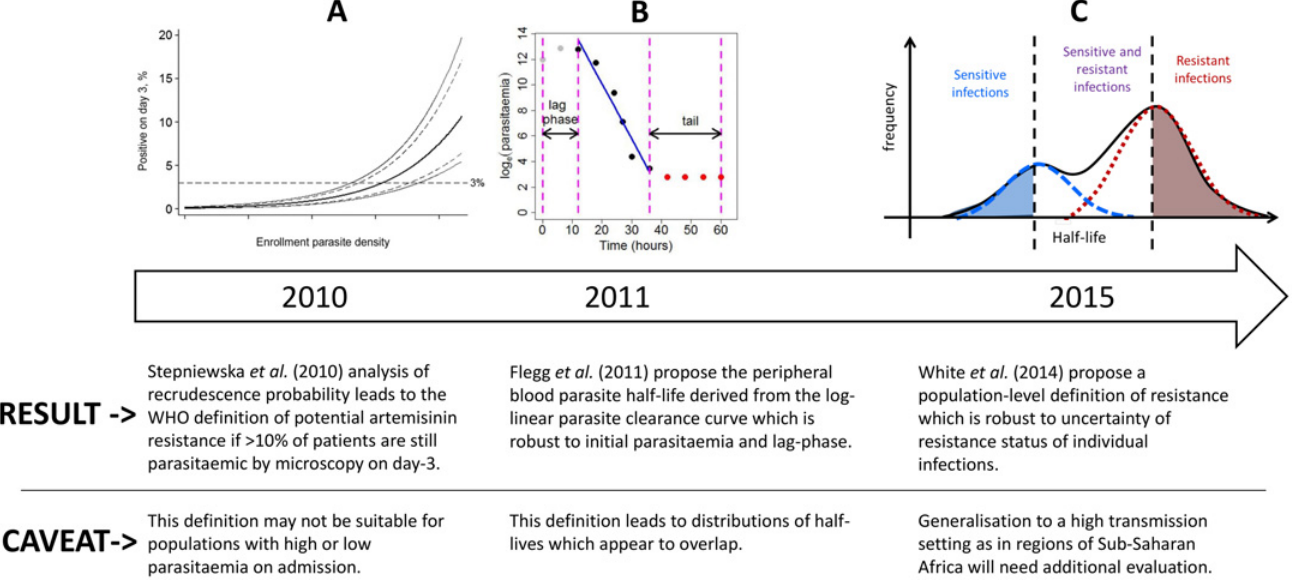
Fig 1. A diagram illustrating the evolution of the definition of artemisinin resistance using parasite clearance data. The first definition is based on the ‘ day-3 ’ parasitaemia [12], the second is defined as the peripheral blood parasite half-life derived from the log-linear parasite clearance curve [10], and the third is the definition proposed in this